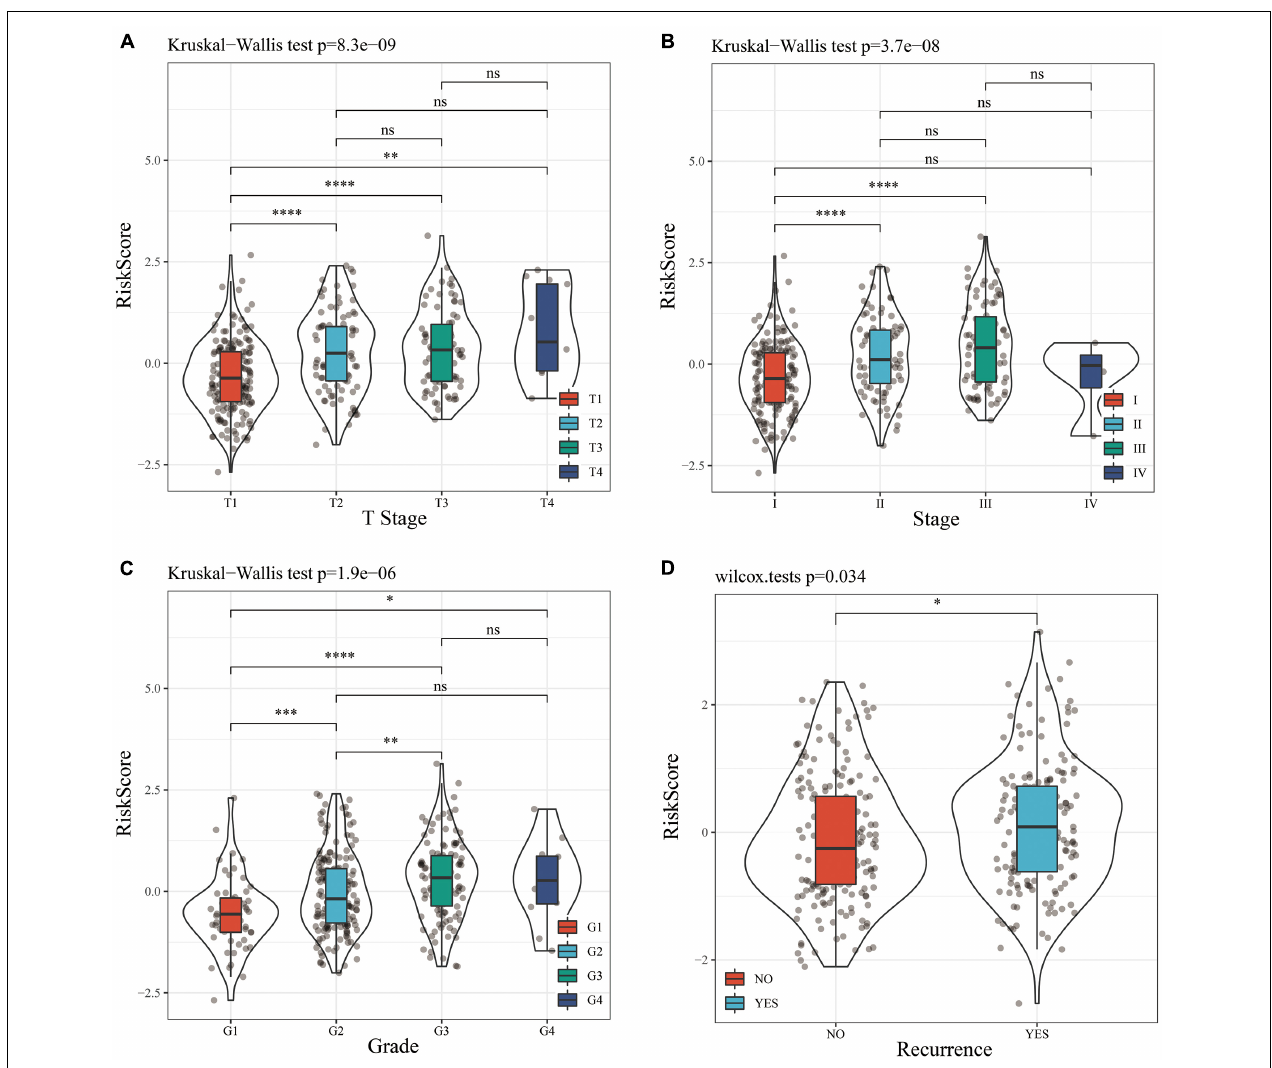
FIGURE 7 | (A) Comparison of RiskScore among T Stage grouping samples. (B) Comparison of RiskScore among stage grouping samples. (C) Comparison of RiskScore among grade grouping samples. (D) Comparison of RiskScore between grouped samples with or without recurrence. * means P value < 0.05; ** means P value < 0.01; *** means P value < 0.005; **** means P value < 0.001; ns , no